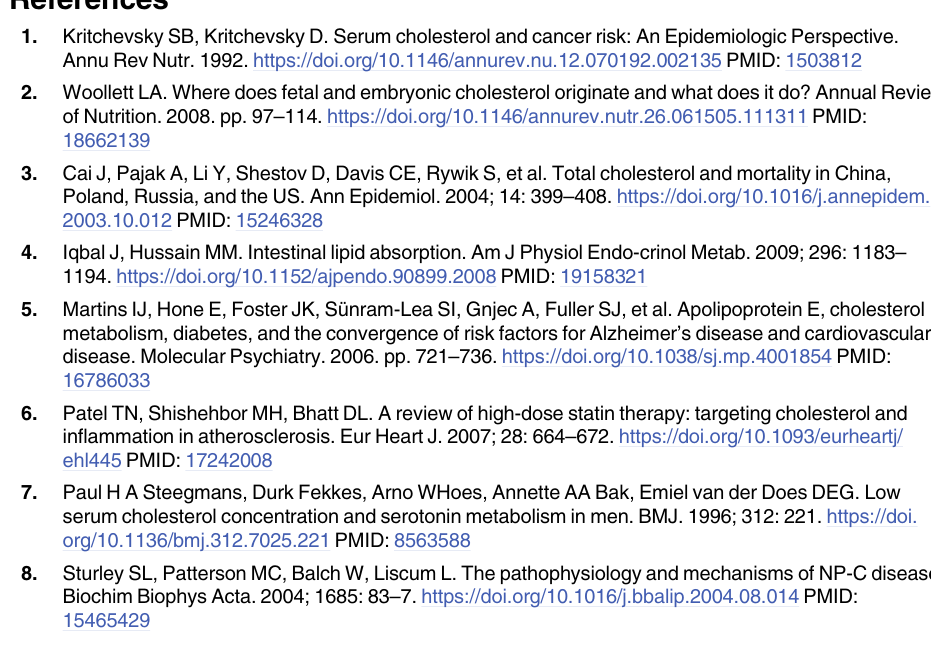
S1 Table. Adult percentage in orthologues of CB1/2 mutants grown for two generations in the absence of cholesterol arrest as L2 � larvae. S2 Table. Dauer percentage in RNAi enhancer screen essays on daf-7 (e1372) worms. For details see